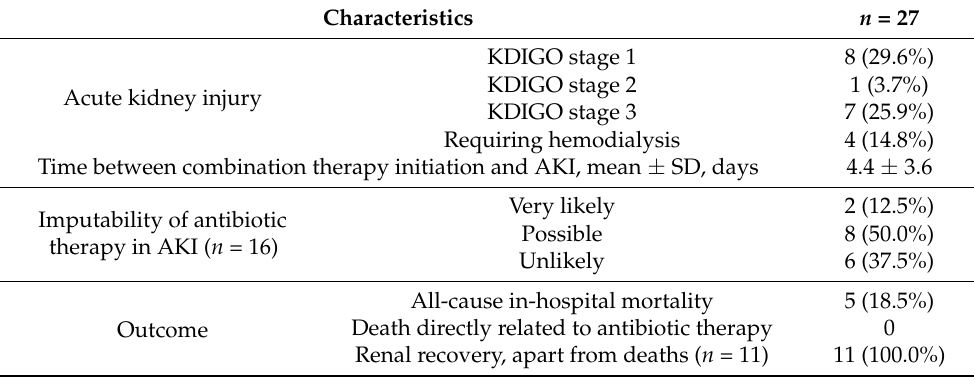
Table 2. Outcome of patients treated with high-dose amoxicillin and cloxacillin combination.